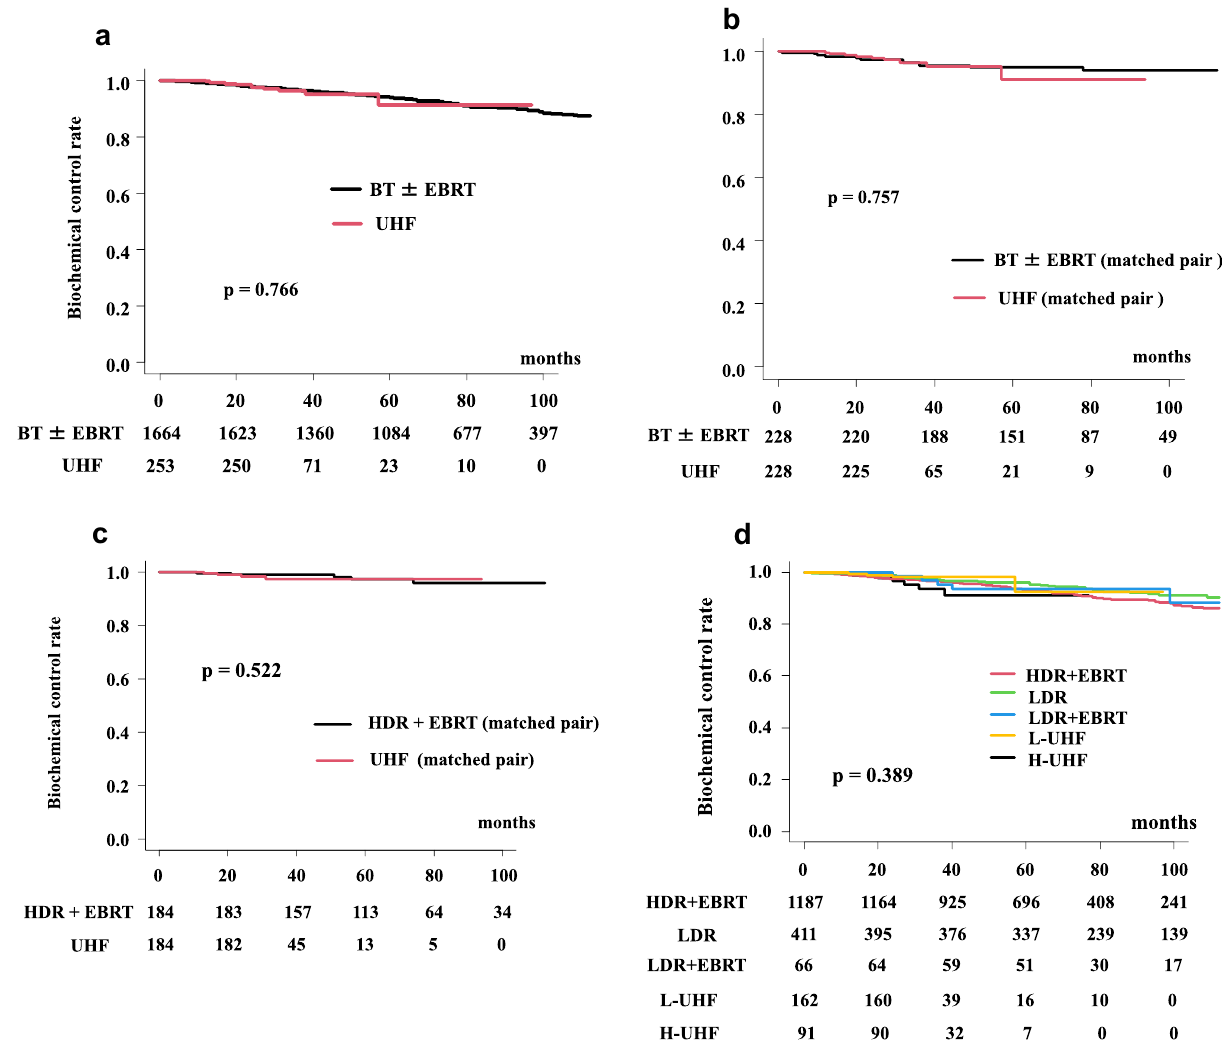
Figure 3. Biochemical control rates between UHF and BT ± EBRT. ( a ) Comparison between UHF and BT ± EBRT in total population. ( b ) Comparison between UHF and BT ± EBRT in matched pair generated by propensity score matching. ( c ) Comparison between UHF and HDR + EBRT in matched pair generated by propensity score matching. ( d ) Comparison among five